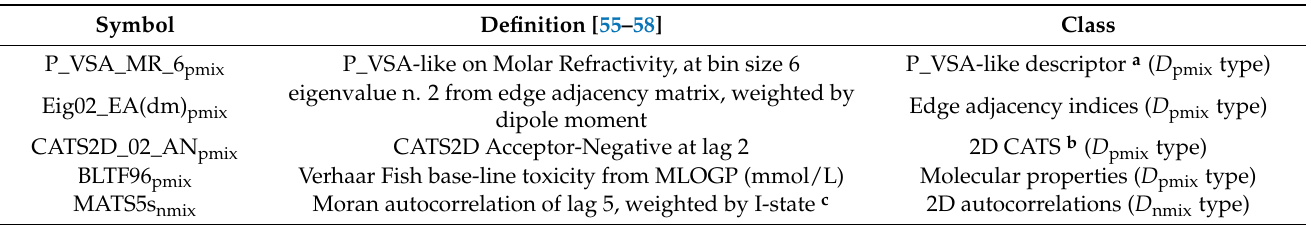
Table 3. The five WM molecular descriptors selected for model M12—Equation